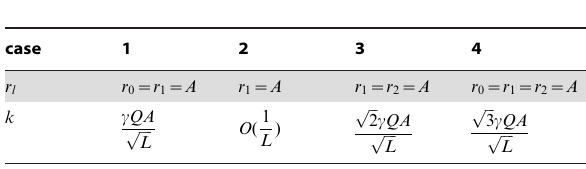
Table 1 implies that the change in mean fitness and error threshold (defined by equation R ~ 1 ) due to neutrality are rather ffiffiffiffi L p small, of the order 1 = . Table 1. Correction terms k : R { QA (in the third row) for 4 different cases of mesa-type fitness, where R is the mean fitness and A is the fitness at the wild sequence S 0